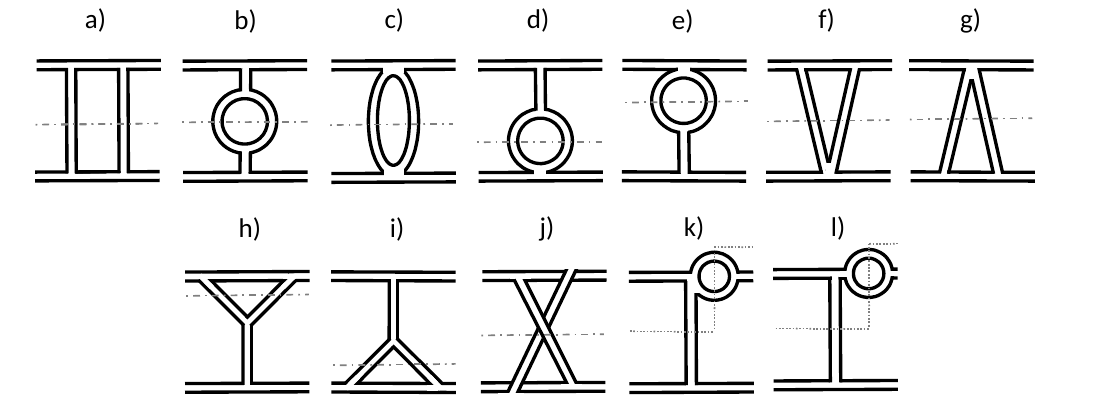
Figure 7 . The topological structures of rungs obtained by cutting the two-loop self energy. The dashed and dotted lines represent the allowed and forbidden cuts, respectively, through the